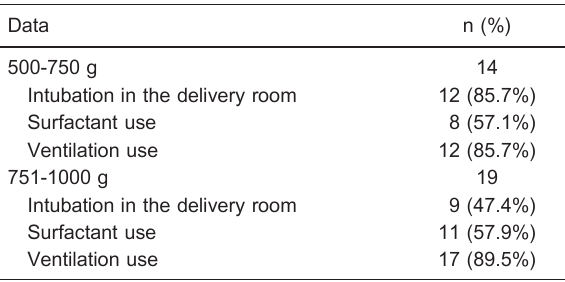
Table 2. Intubation in the delivery room, surfactant use and mechanical ventilation during the first 5 days of